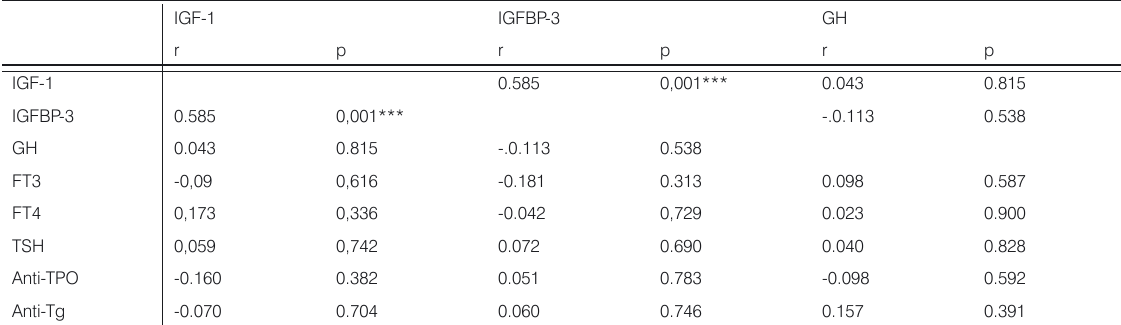
Table 3. The correlations among GH, IGF-1, IGFBP3 and thyroid hormones and antibodies in control